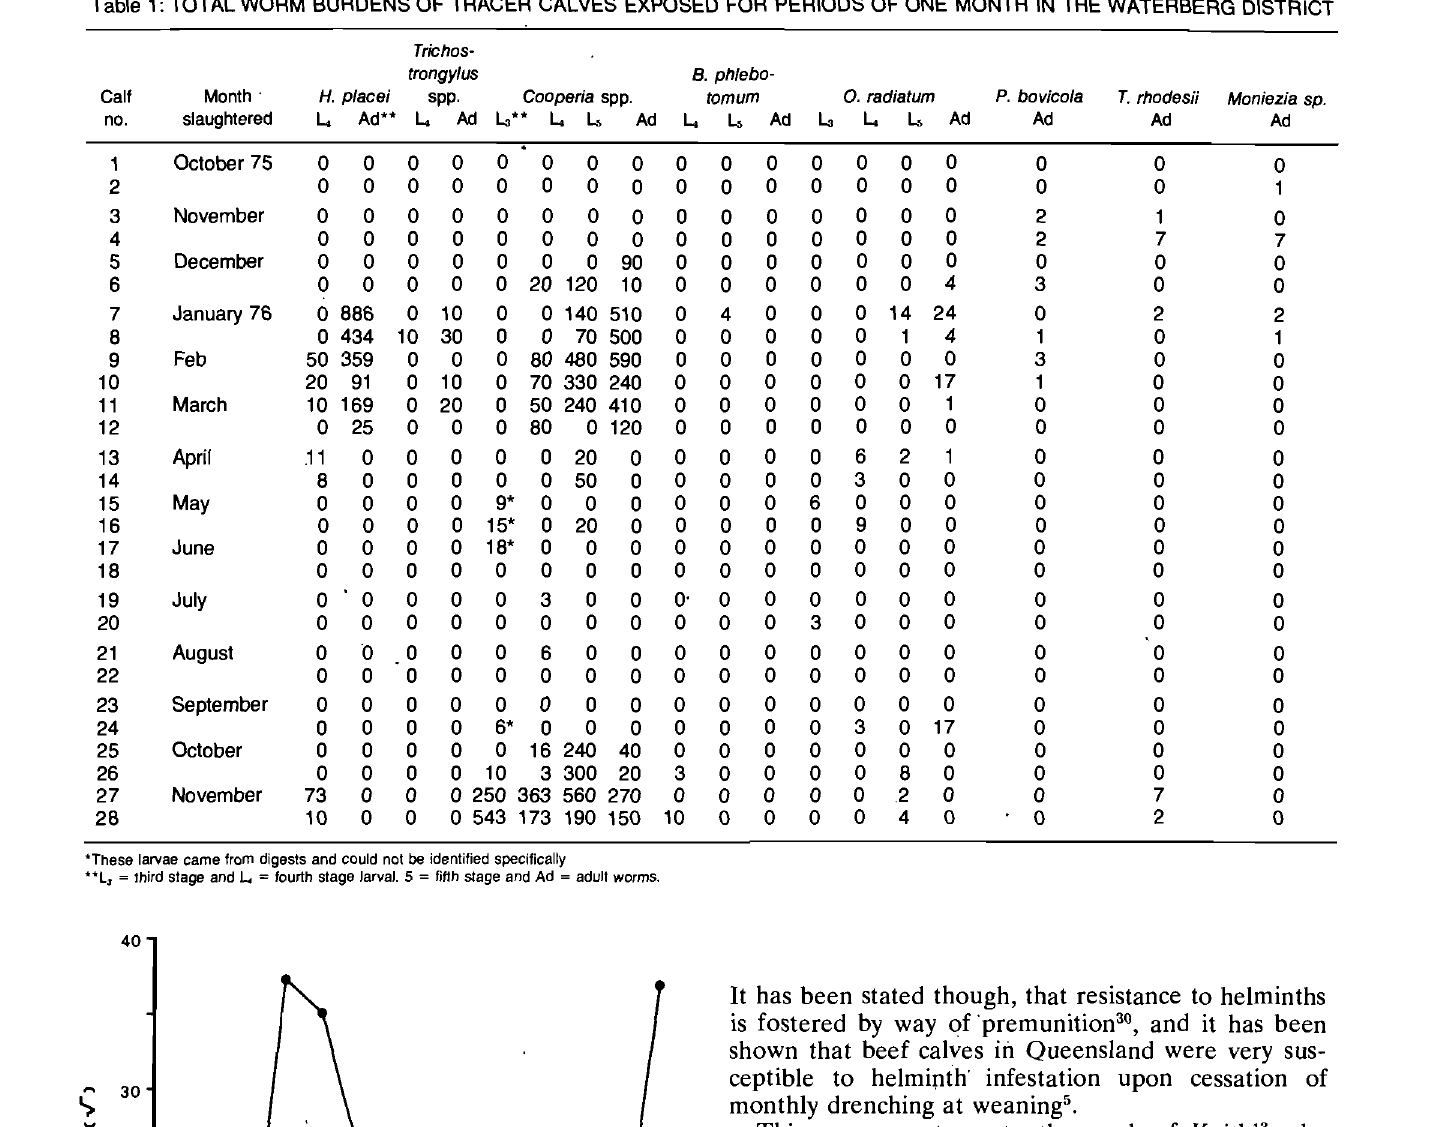
Table 1: TOTAL WORM BURDENS OF TRACER CALVES EXPOSED FOR PERIODS OF ONE MONTH IN THE WATERBERG DISTRICT Trichos- trongylus B. phlebo- Calf Month' H. placei